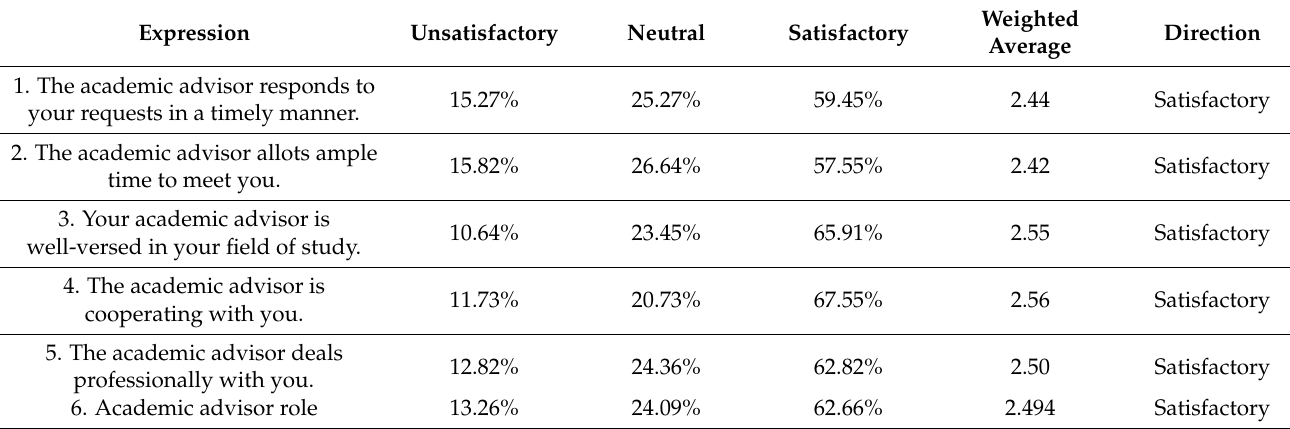
Table 13. Student trends about the Academic Advisor in